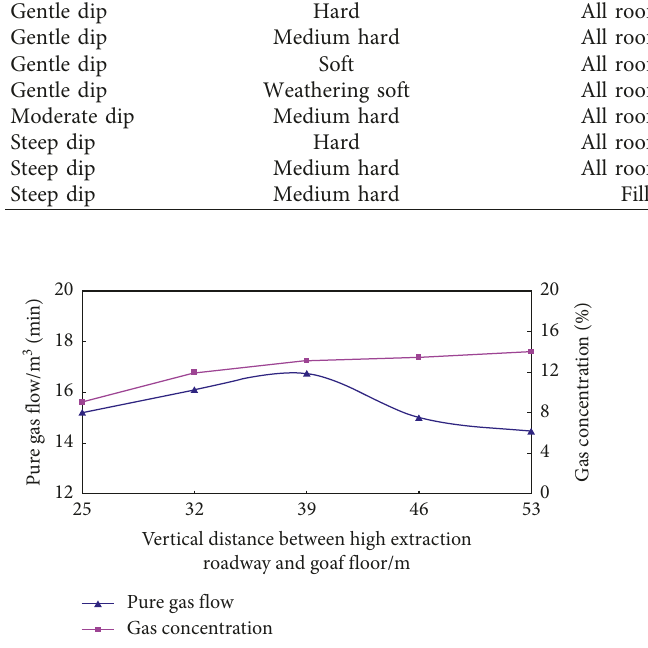
Figure 2: Extrication effect under different vertical distances be- tween the high extraction roadway and the goaf